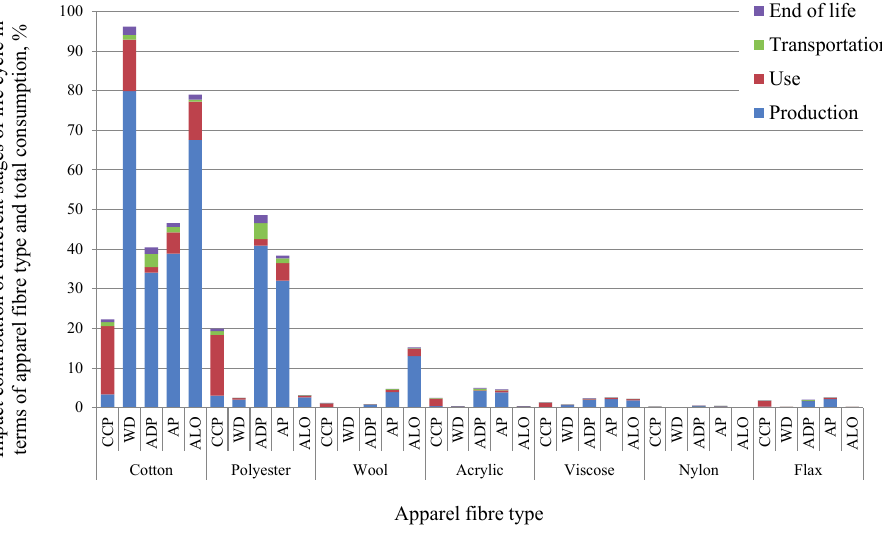
Fig. 11. Impact contribution of different stages of the life